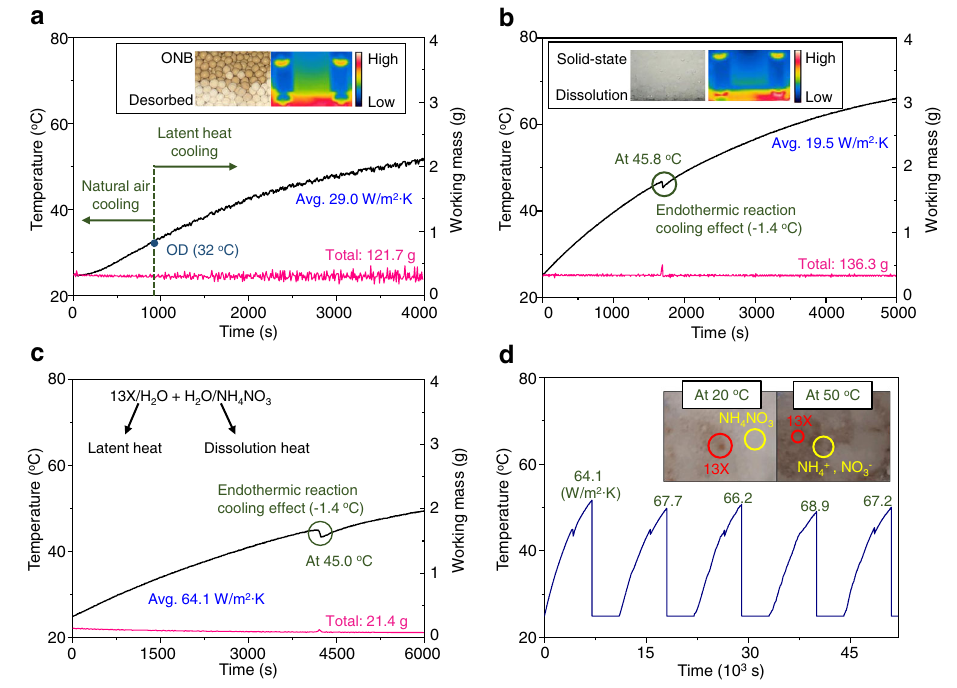
Fig. 4 | Heat dissipation performance in terms of cooling methods. a Latent cooling. b Endothermic reaction cooling. c Water desorption-driven endothermic